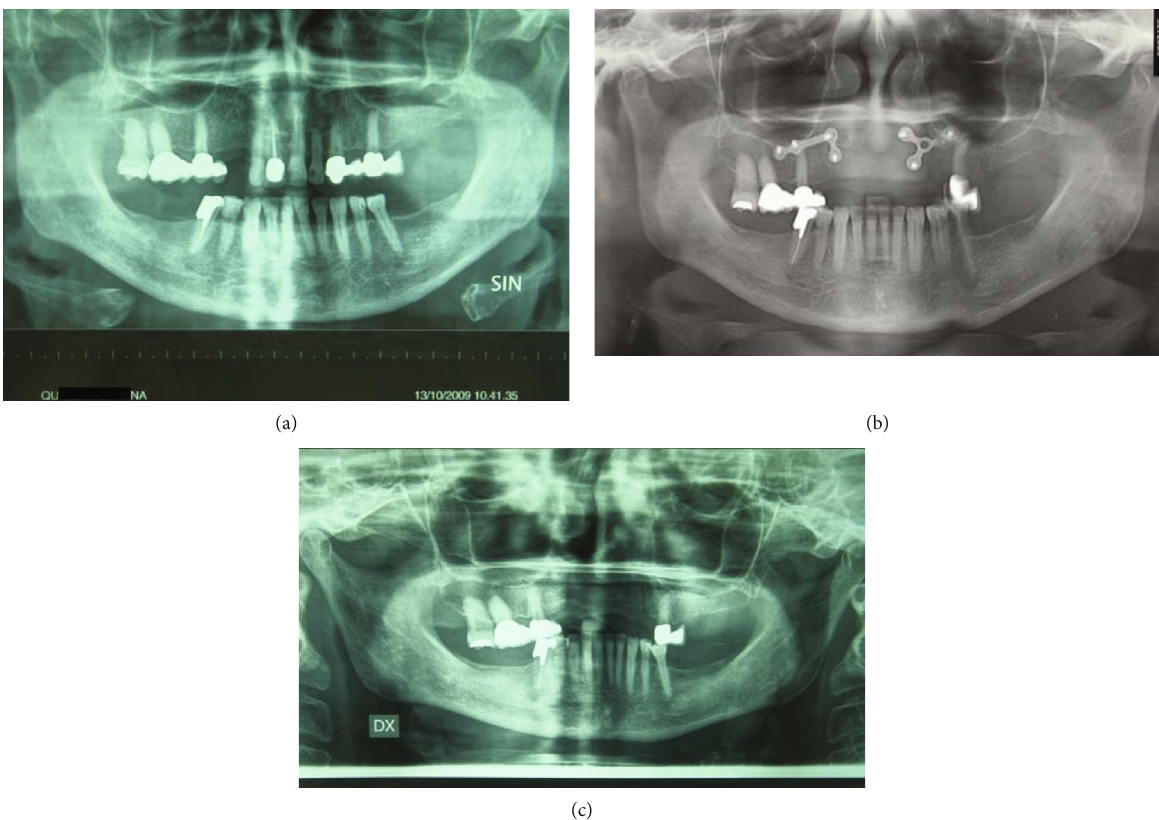
Figure 2: (a) Preoperative panoramic X-ray documenting an osteolytic lesion of the premaxilla. (b) Postoperative panoramic X-ray documenting the correct position of graft and fi xation means. (c) Panoramic X-ray after removal of plates and screws (24-month follow- up) revealing signs of resorption and lower radiopacity of the graft